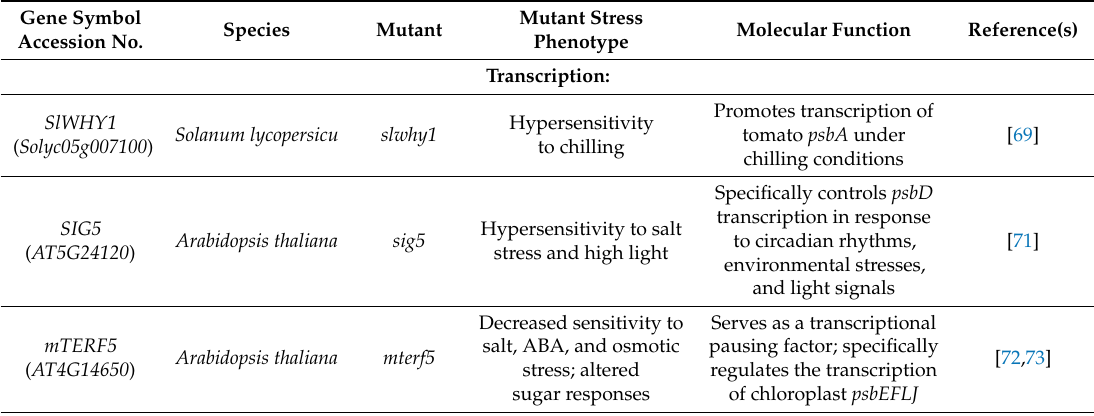
Table 1. Chloroplast gene expression and stress response